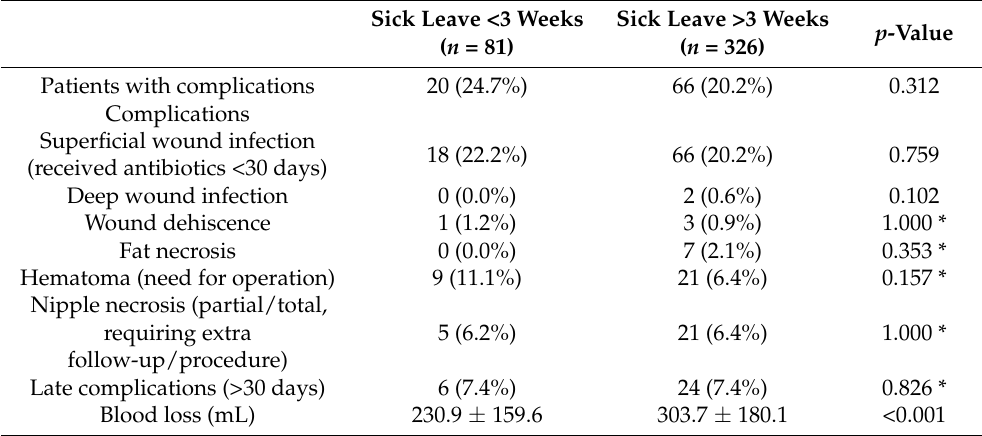
Table 4. Postoperative complications at follow-up in patients who had a less than 3 weeks of sick leave versus over 3 weeks of sick